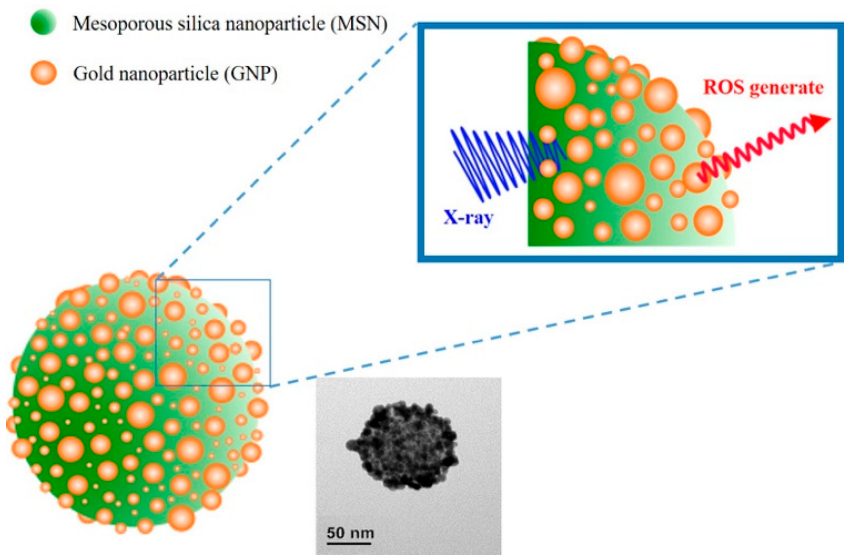
Figure 1. Schematic illustration of X-ray-induced photodynamic therapy (PDT) with pollen-structured gold clusters (PSGCs).